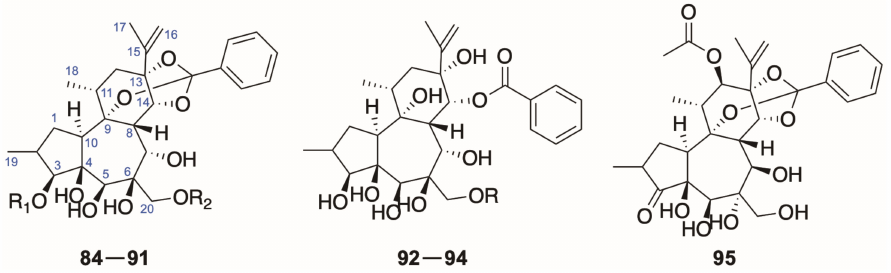
Figure 4. Structures of genkwanines ( 84 – 95 ).